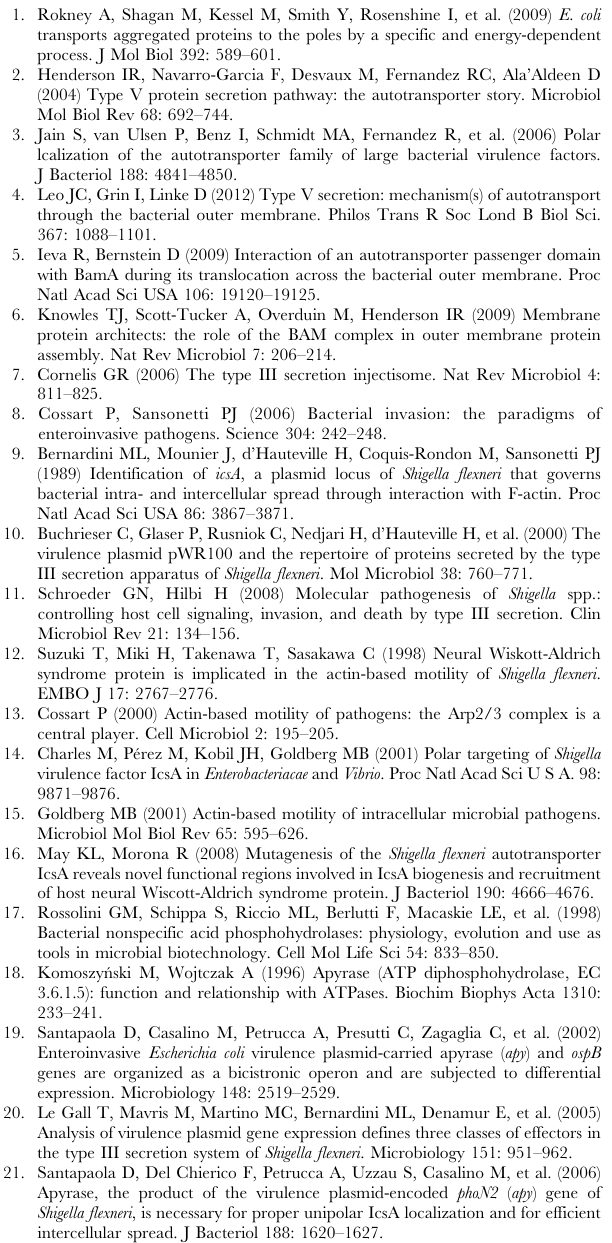
Table S2 Primers used in this